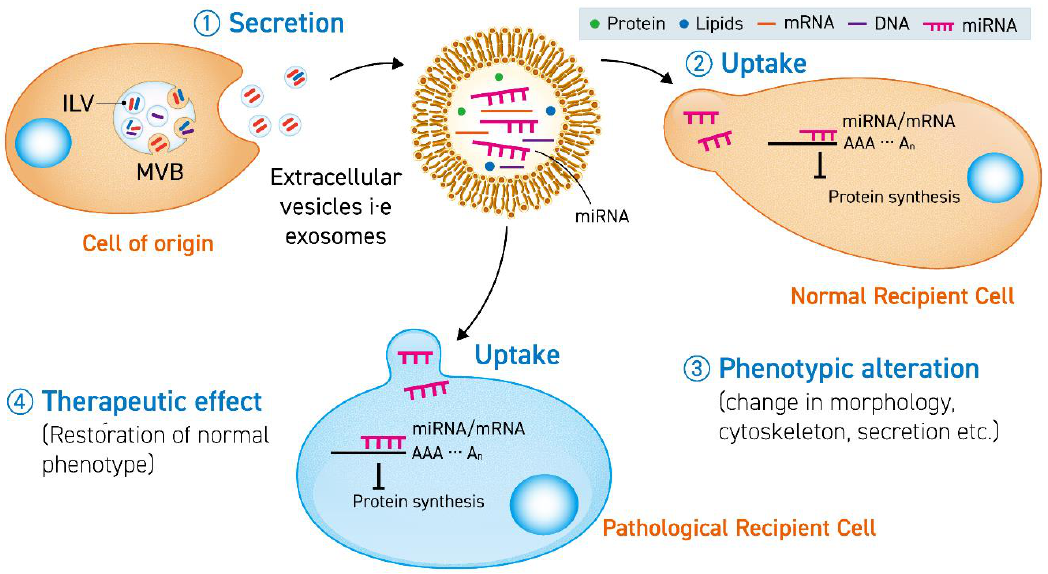
Figure 1. The secreted extracellular vesicle (EV) (1) carrying miRNA is uptaken by a normal cell (2) or pathological cell to cause a phenotypic change (3) or therapeutic effect (4) by translational inhibition of mRNA in the recipient cells. ILV stands for intraluminal vesicles and MVB stands for multivesicular bodies.